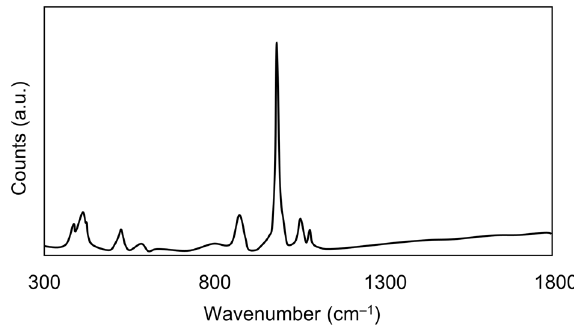
Fig. 2 Raman spectrum of DCPD seed material